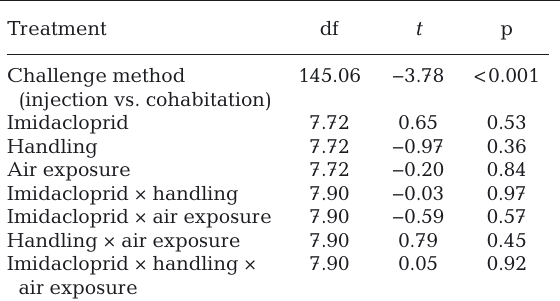
Table 3. Generalized linear mixed model testing the effect of challenge method, different stressors and their interactions on the level of OsHV-1 DNA in the gill and mantle tissues of dead Pacific